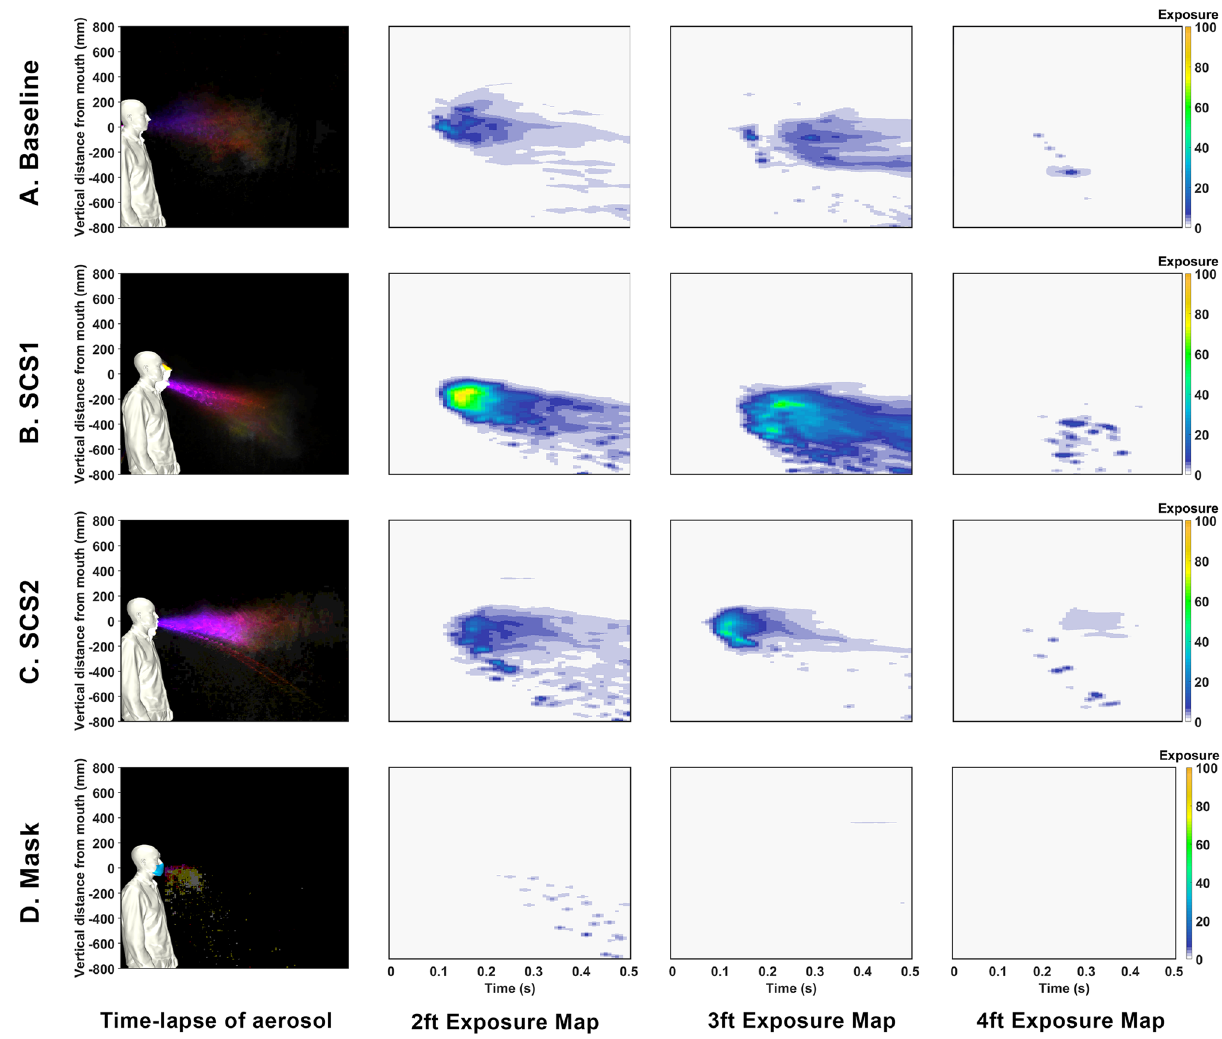
Figure 3. Summary of aerosol exposure from Human Sneeze with various modifiers. Column 1 is a time- lapse colored by time. Column 2–4 indicate exposure levels at 0.61 m (2 ft), 0.914 m (3 ft), and 1.219 (4 ft), respectively. Cases compare ( a ) baseline saliva, ( b ) SCS1, ( c ) SCS2, and ( d )